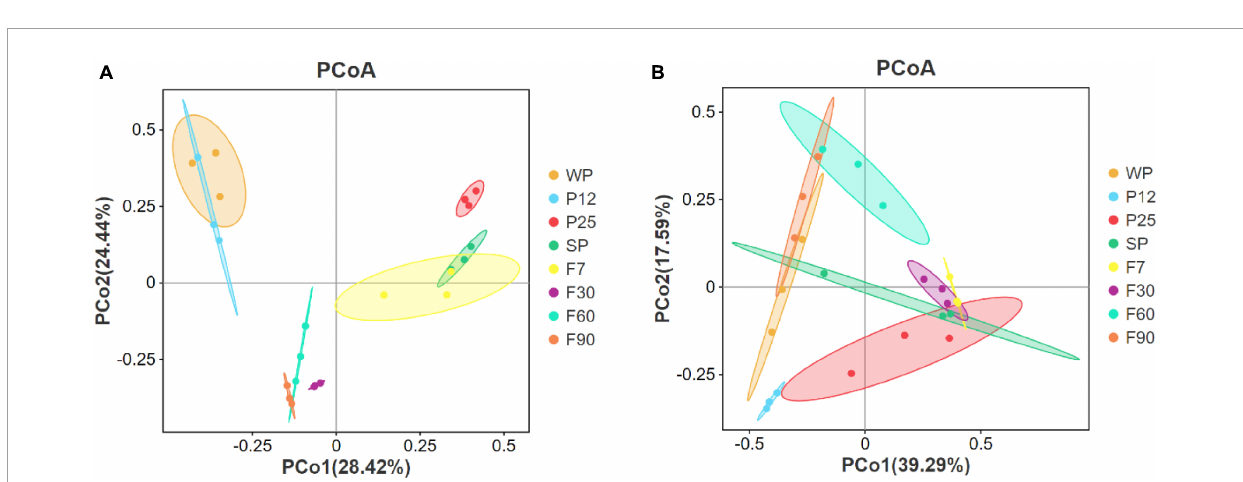
FIGURE4 Principal coordinate analysis (PCoA) of the bacterial (A) and fungal (B) communities based on Bray-Curtis distances.